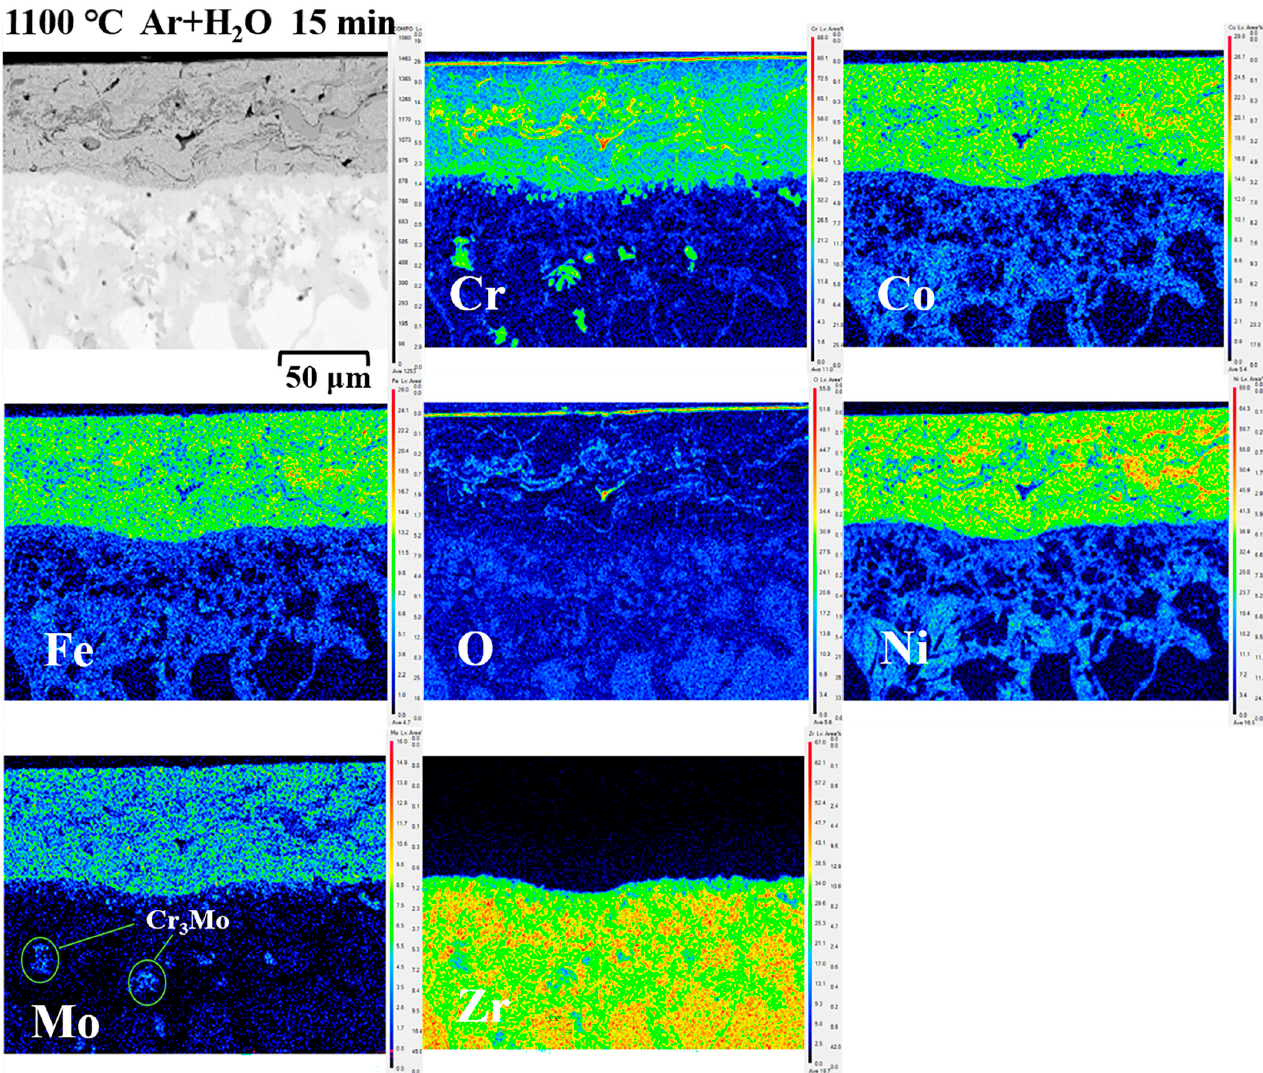
Figure 6. EPMA elemental mapping of the FeCoNiCrMo coatings after 15 min of oxidation at 1100 °C in a steam environment.